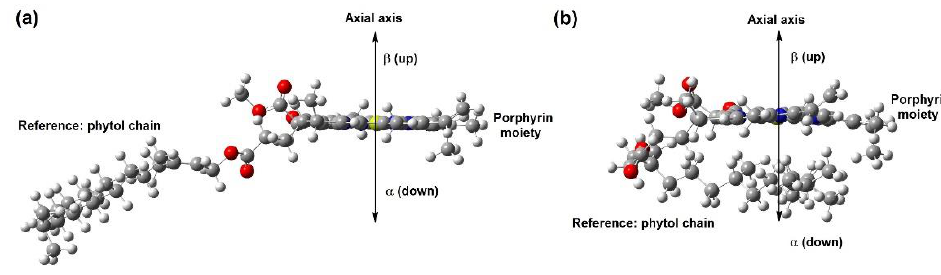
Figure 3. ( a ) Unfolded and ( b ) folded chl a .